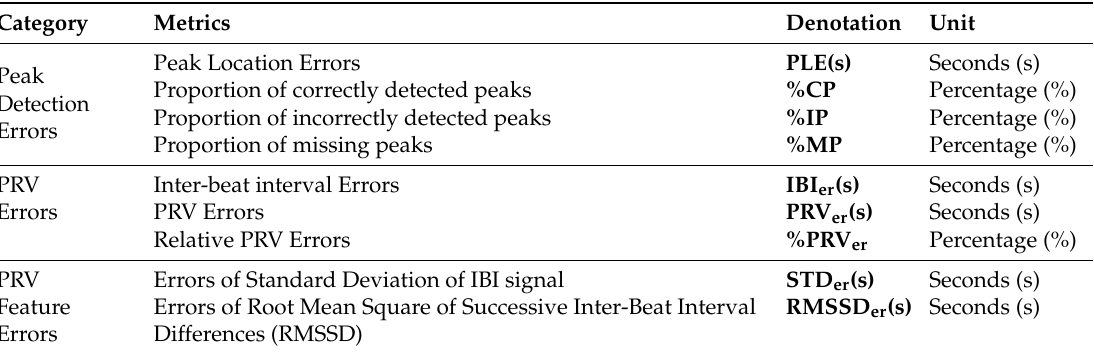
Table 1. Evaluation Metrics.